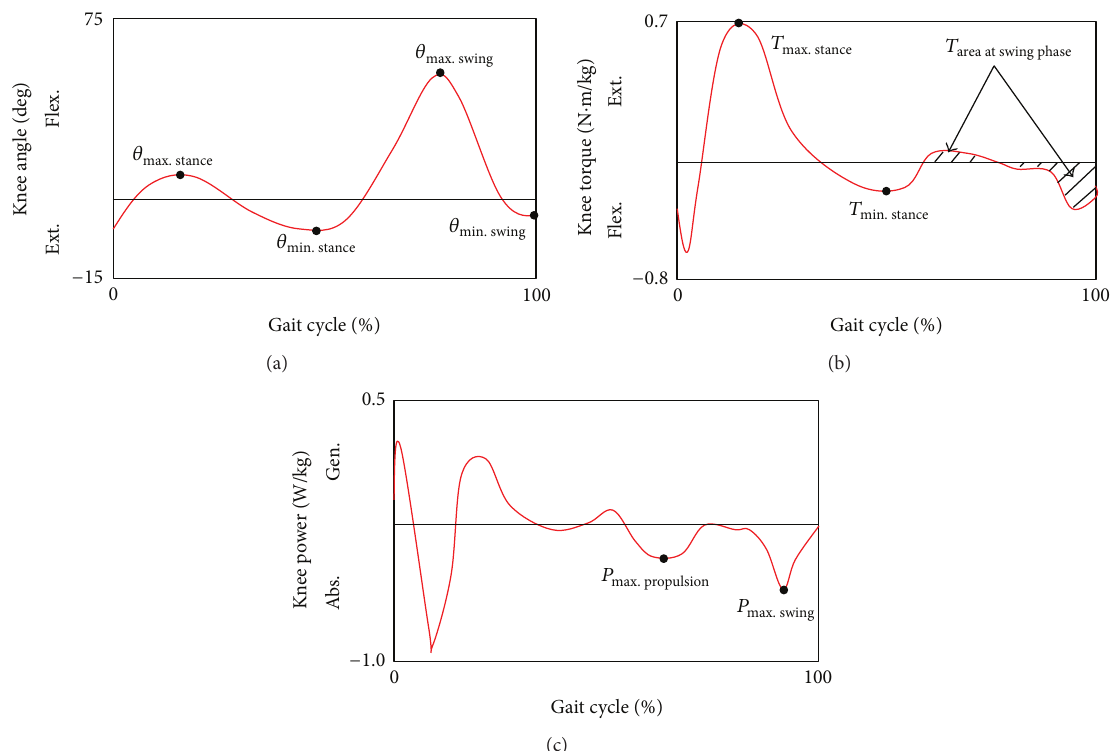
Figure 2: (a) Angle, (b) torque, and (c) power of the knee throughout the gait cycle and including various nine subparameters. Gait profiles were based on work of Segal et al., 2006